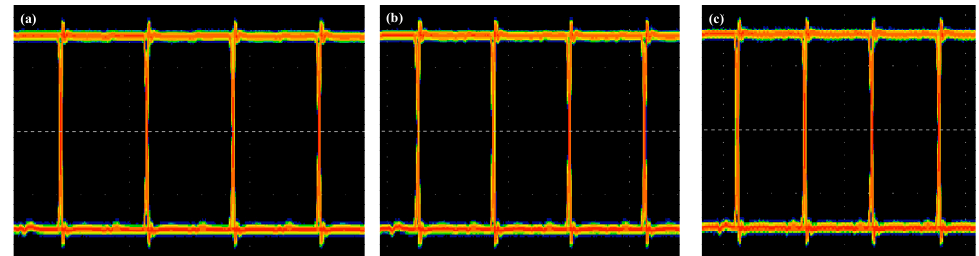
Figure 11. Eye diagrams after DSR. ( a ) 60 Mbps; ( b ) 800 Mbps; ( c ) 100 Mbps.